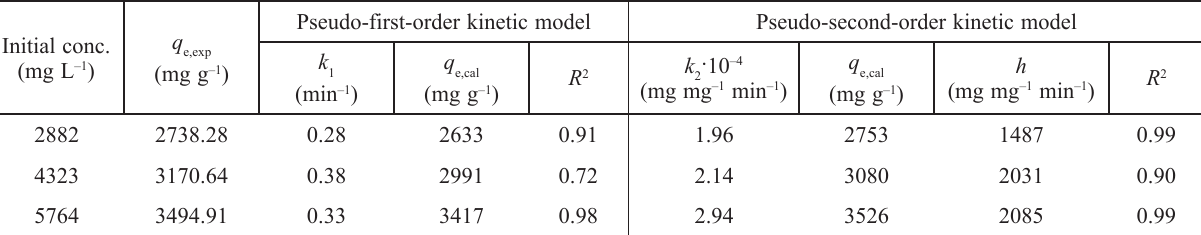
Table 5 – Comparisons of the kinetic models adsorption rate constants, initial adsorption rate, and calculated and experimental values obtained at different acrylic acid concentrations q e Initial conc. (mg L –1